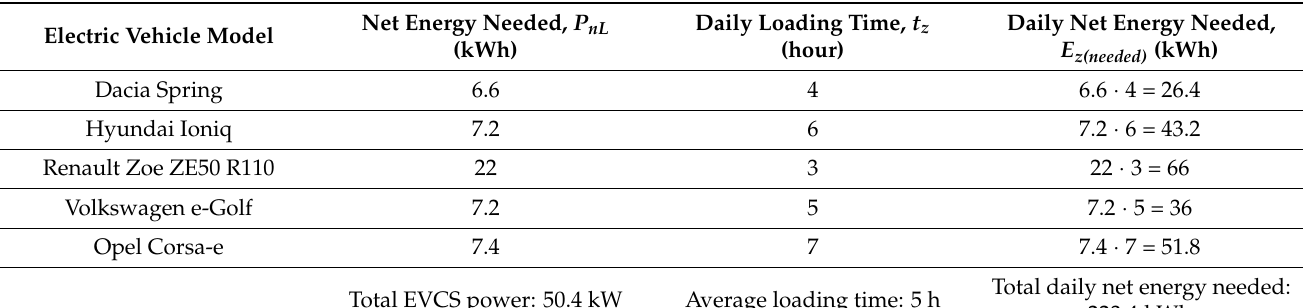
Table 4. Net energy needed and loading time for each EV